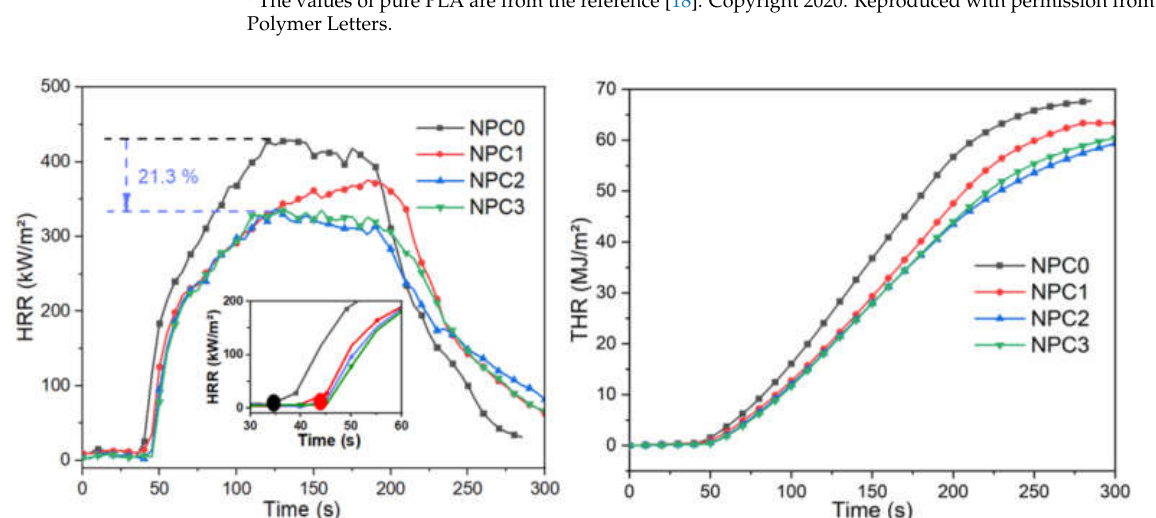
Table 5. Results from CCT for PLA-OCC biocomposites. Sample PHRR/(kW/m²) TTI/(s)